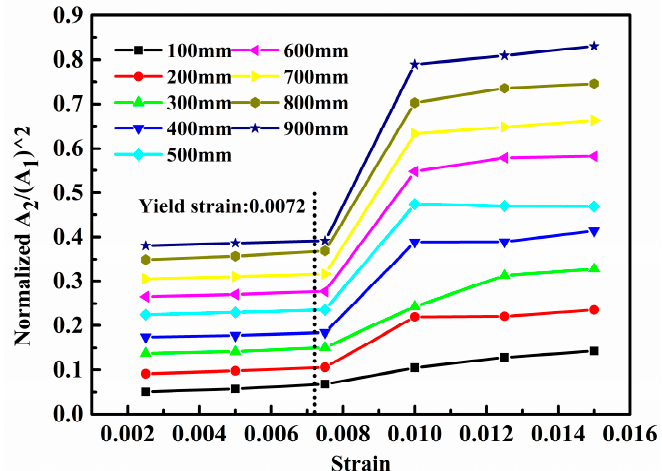
Figure 10. Normalized acoustic nonlinearity versus strain with the model.